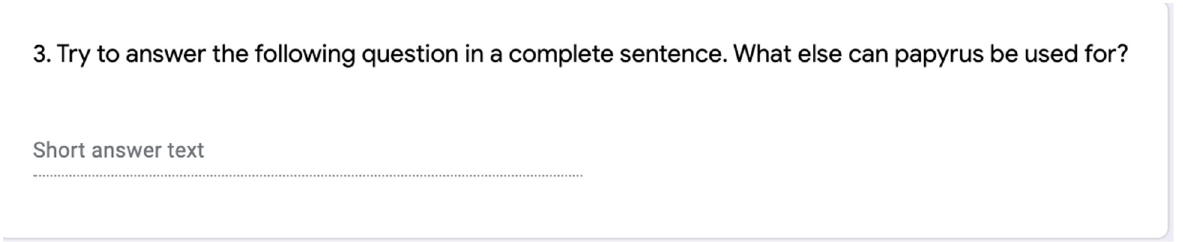
Figure 10. Listening assessment example (seventh